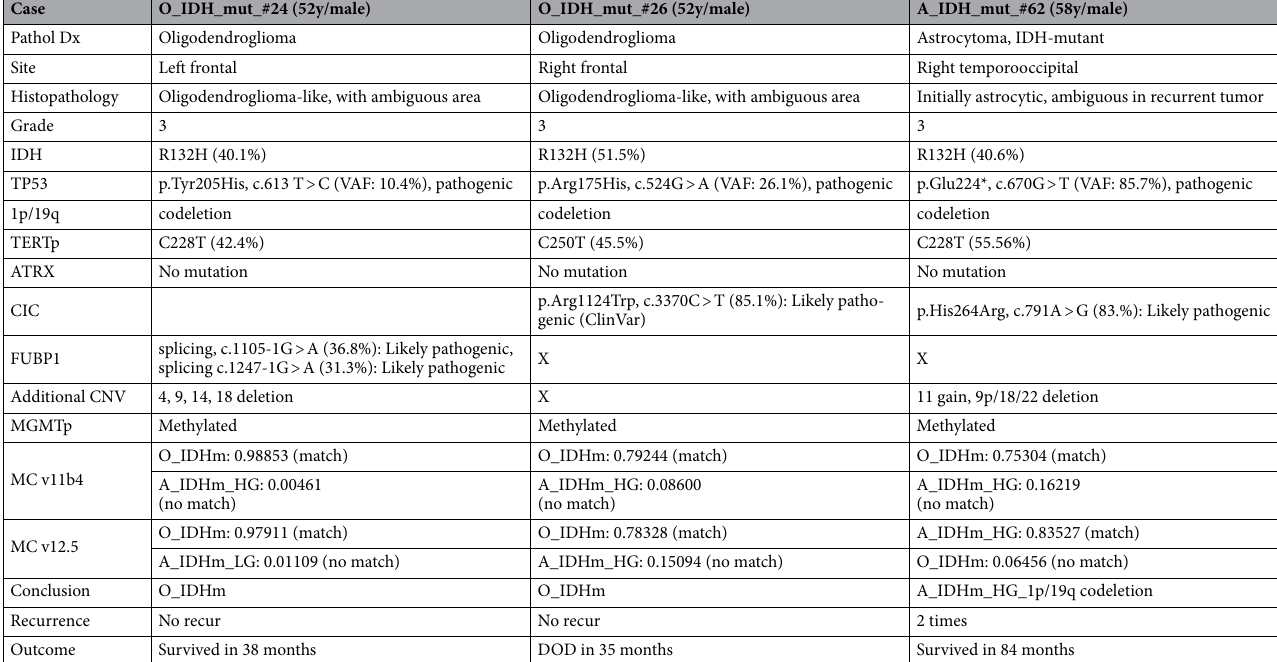
Table 5. The histologically and genetically confusing cases with DNA methylation profiling, which are TP53- mutant oligodendrogliomas and 1p/19q-deleted astrocytoma, IDH-mutant. DOD death of